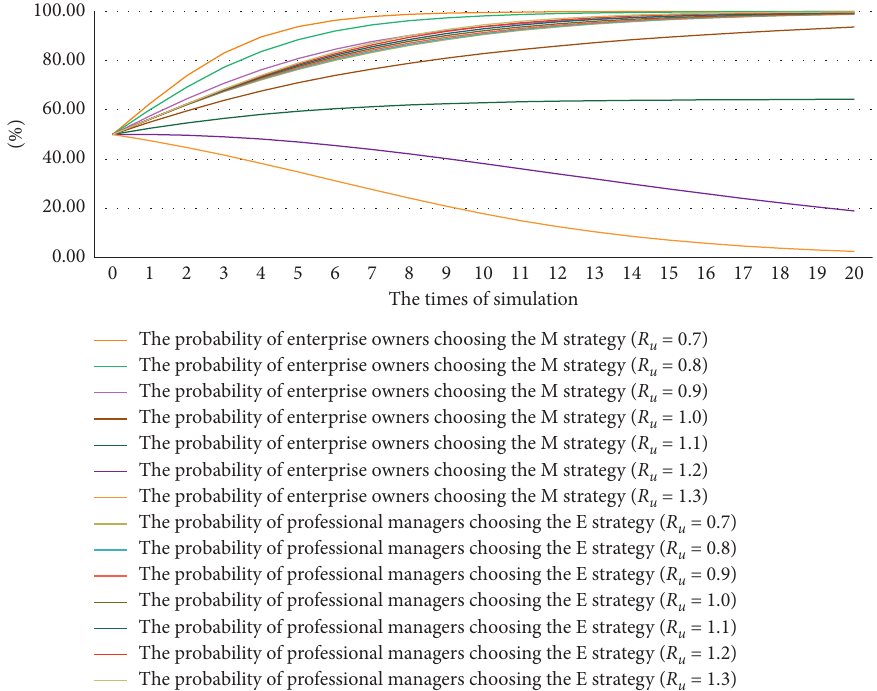
Figure 13: The impact of R u on the evolutionary